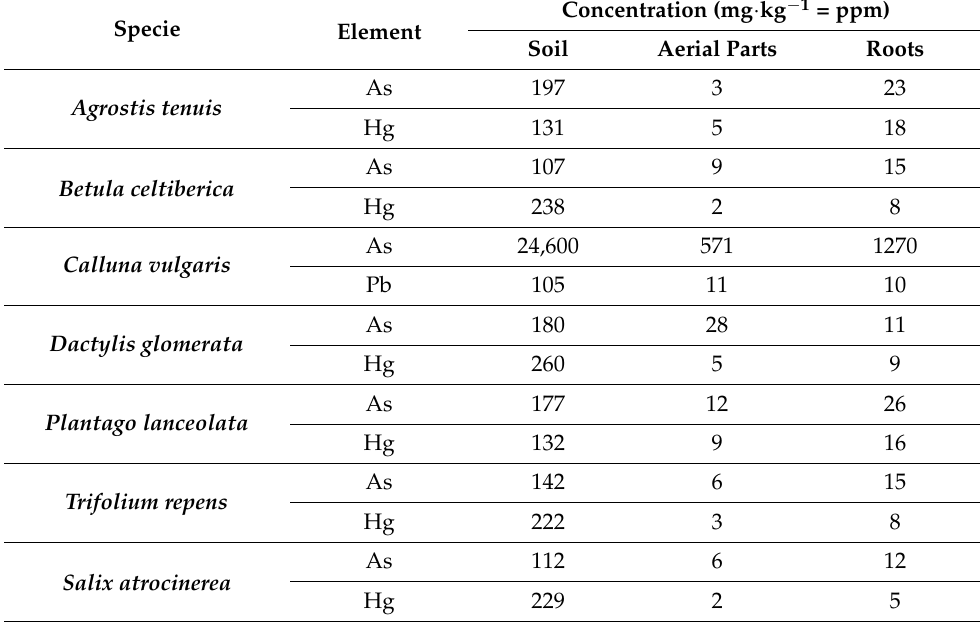
Table 4. Average content of metal(loid)s in soil and plant samples for the seven selected species analyzed (n = 3, uncertainties below 10% for all determinations). Data for elements with soil contents below 100 mg · kg − 1 (= ppm) are not indicated and were not considered for the calculation of accumulation factors (see Table 5).